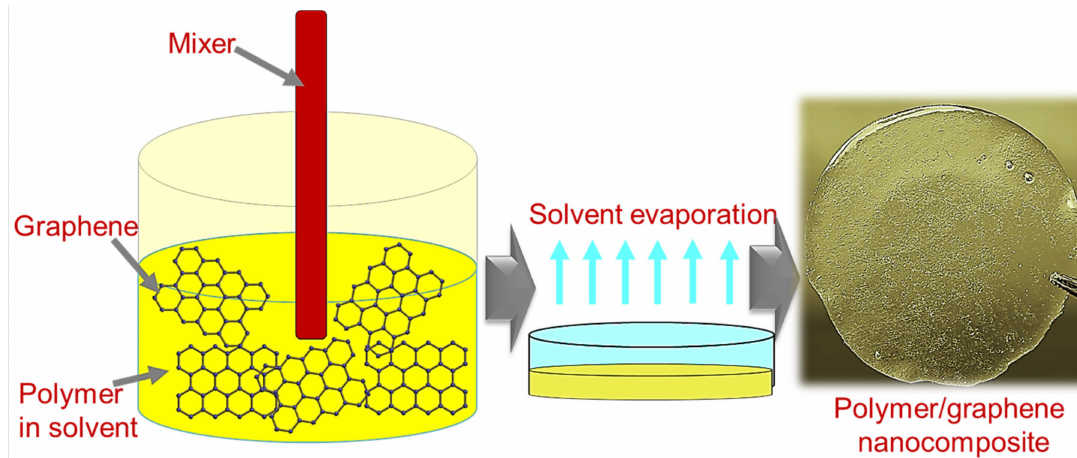
Figure 2. Solution mixing set-up.